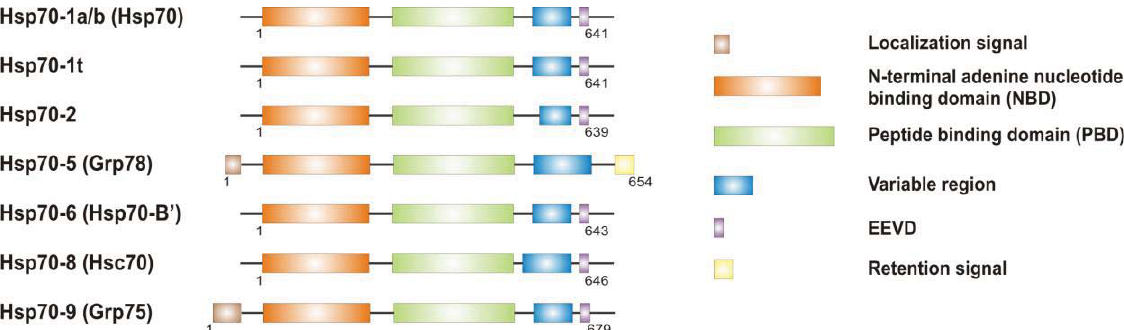
Figure 3. Structure and domains of human Hsp70 family member proteins. Human Hsp70s contain distinct functional domains, including a 30 kDa peptide binding domain (PBD), responsible for substrate binding; a 45 kDa nucleotide binding domain (NBD), which includes the ATP-binding cleft domain; and two other domains shared by most of the family members: a carboxyl-terminal EEVD motif, or chaperone motif, and a variable region at the EEVD N-terminal. More specific localization and the retention signals are found in Hsp70-5 and Hsp70-9 proteins, to guide chaperone localization into the endoplasmic reticulum (ER) or the mitochondrial lumen,